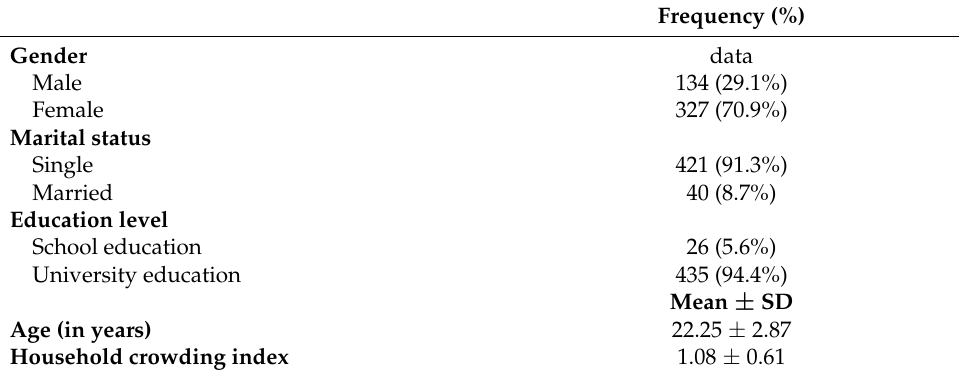
Table 1. Sociodemographic characteristics of the study sample (N =